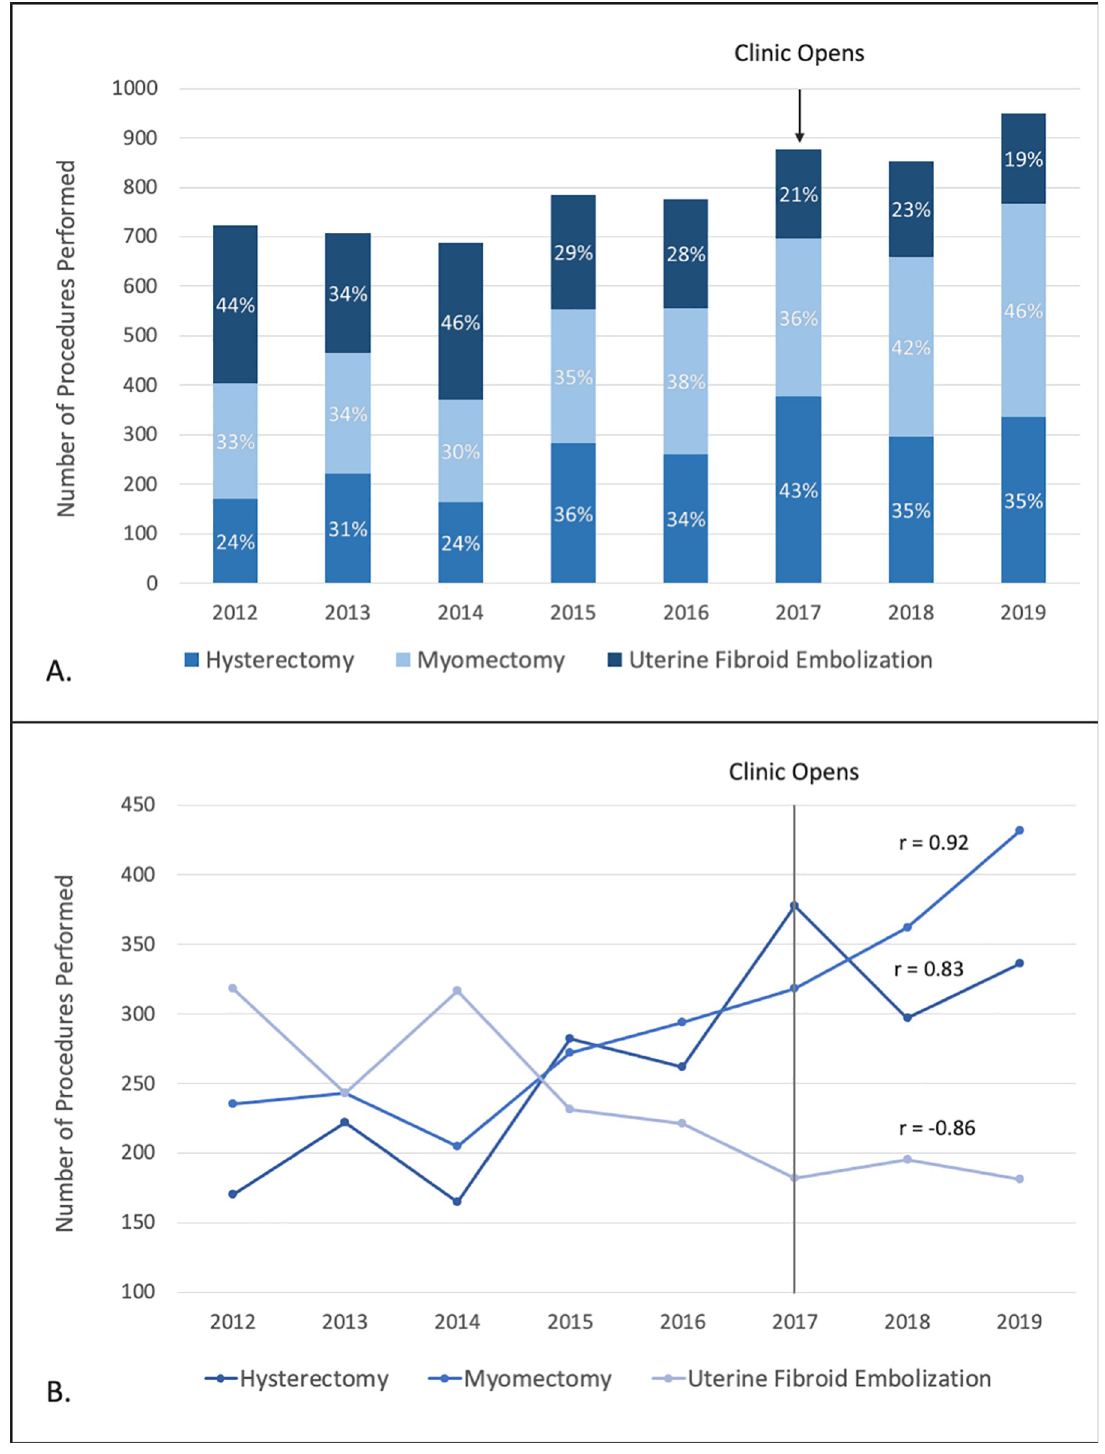
Fig 1. Annual rate of procedures for symptomatic uterine fibroids within the healthcare system as a whole displayed in terms of relative percentages of one procedure compared to others (A) and changes over time with Pearson correlation coefficiencts (B). All coefficients were statistically significant (p �